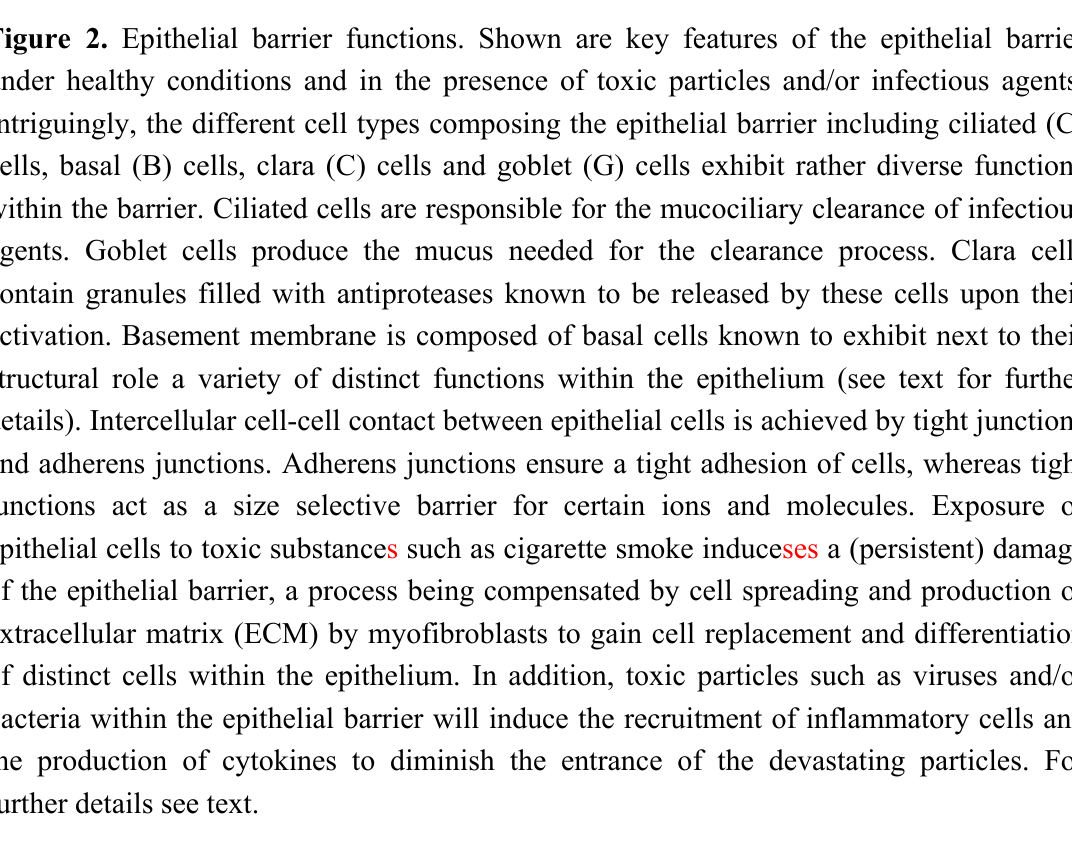
Figure 2. Epithelial barrier functions. Shown are key features of the epithelial barrier under healthy conditions and in the presence of toxic particles and/or infectious